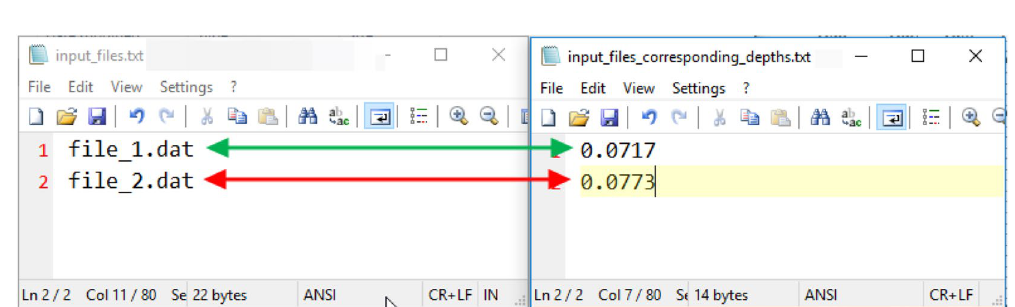
Figure 3. ( A ) Raw velocity signal, ( B ) Signal filtered with SNR method only, ( C ) Signal filtered with correlation method only, ( D ) Signal filtered with acceleration thresholding method only, ( E ) Signal filtered using all the methods mentioned above.